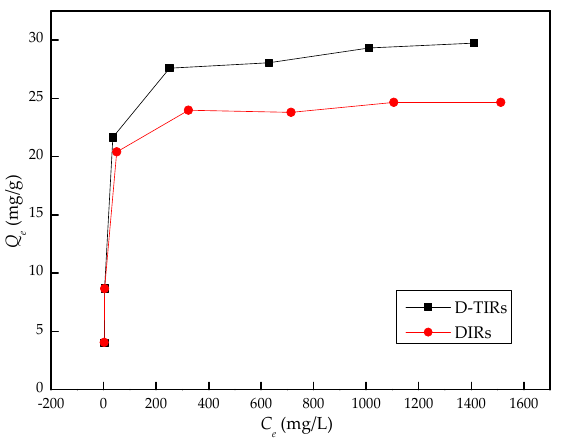
Figure 4. Loading capacity of SIRs for V(IV) at different vanadium concentrations.